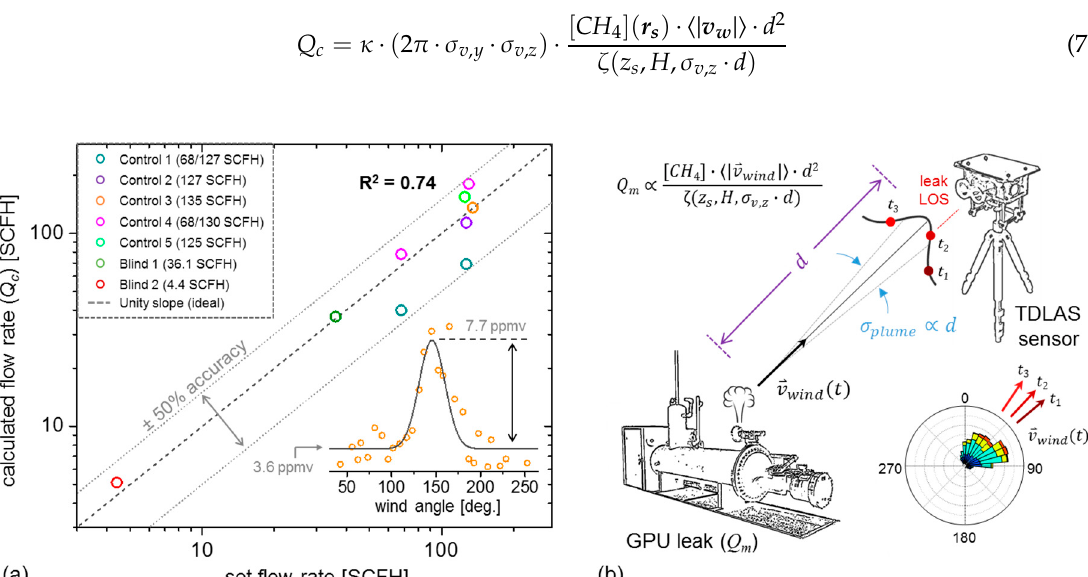
Figure 9. ( a ) Demonstration of the source emission magnitude consistency with the Gaussian plume model. The ideal linearity is given by the gray line (unity slope, dashed), with the 50% accuracy bounds (dotted lines). The inset shows an example of the measured Gaussian profile and its corresponding fit (Control 3) measured across a range of wind angles. ( b ) Pictorial demonstration of the Gaussian profile measurement. As the wind velocity vector varies ( t 1 to t 3 ), the TDLAS sensor uses a single line-of-sight (LOS) to probe different parts of the plume.